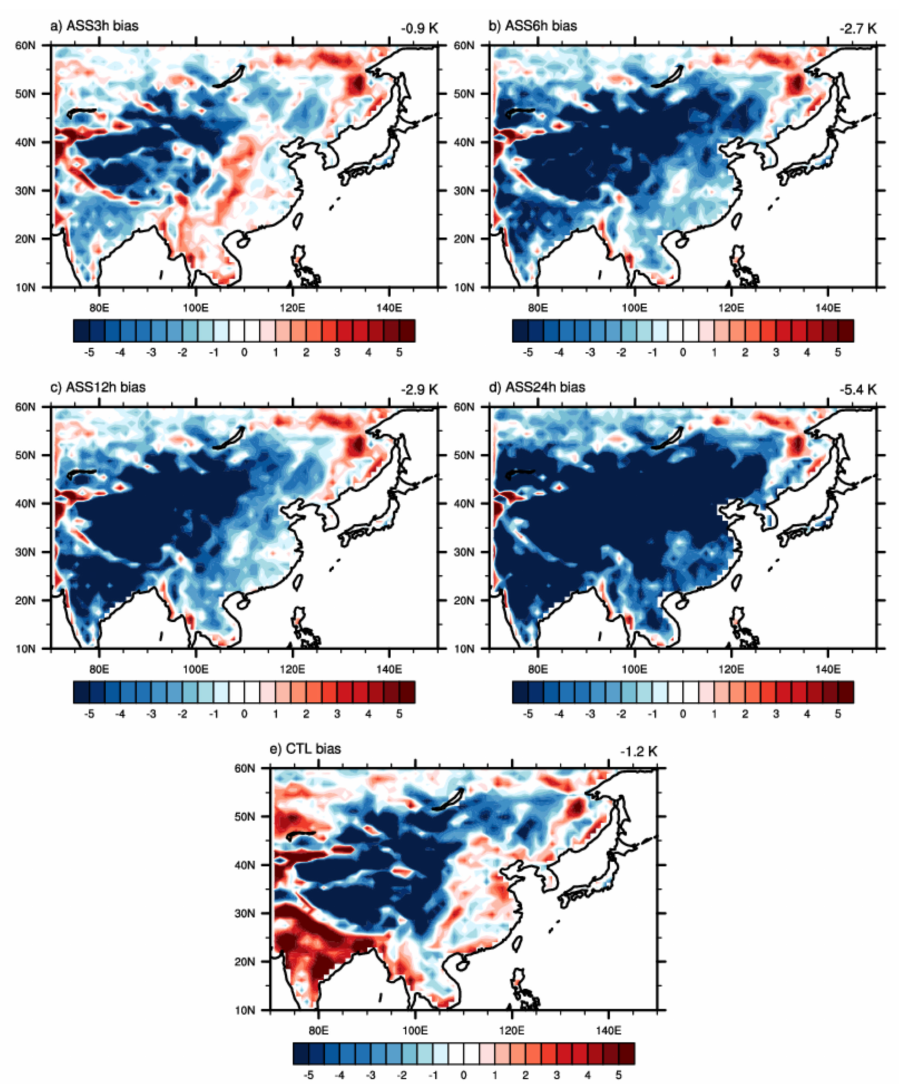
Figure 4. The spatial distributions of the daytime daily-mean LST bias (K) versus the MODIS data for the assimilation experiments with ( a ) 3 h, ( b ) 6 h, ( c ) 12 h, and ( d ) 24 h time frequencies and ( e ) the CTL